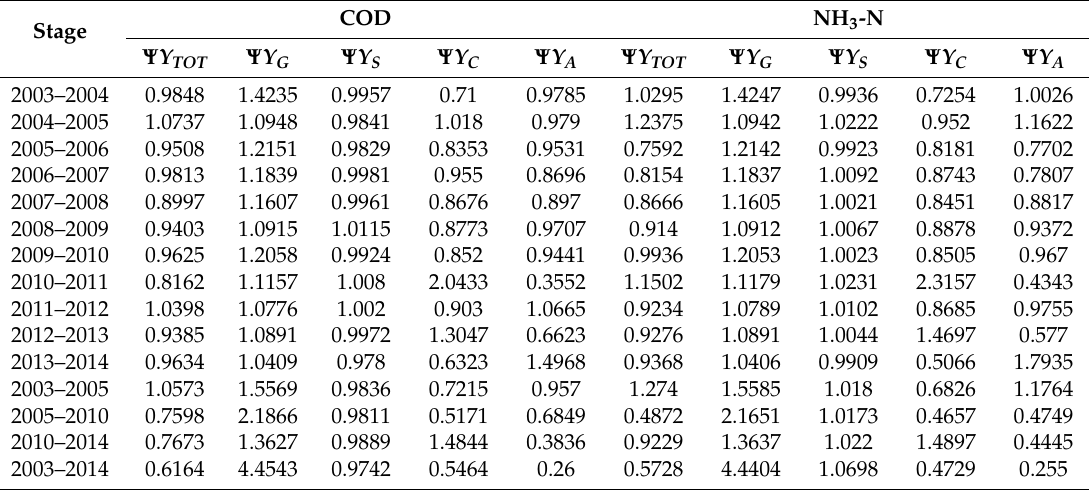
Table A2. Detailed multiplicative decomposition results of COD and NH 3 -N changes.